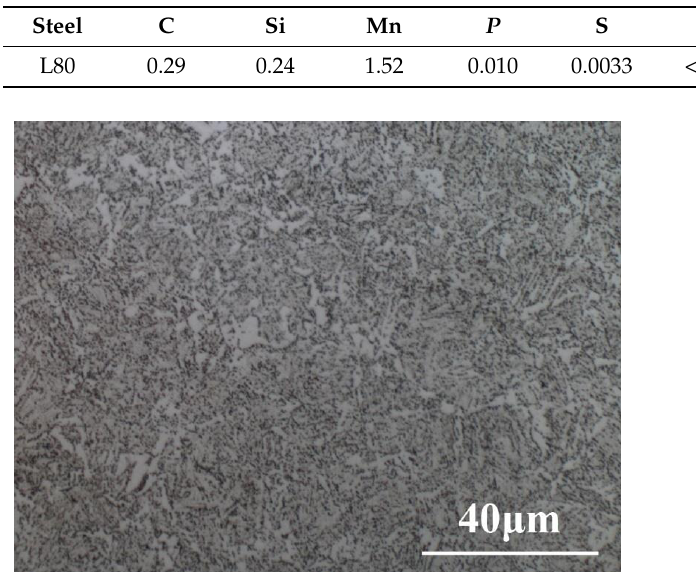
Table 1. Chemical composition of casing steels (unit: wt%).